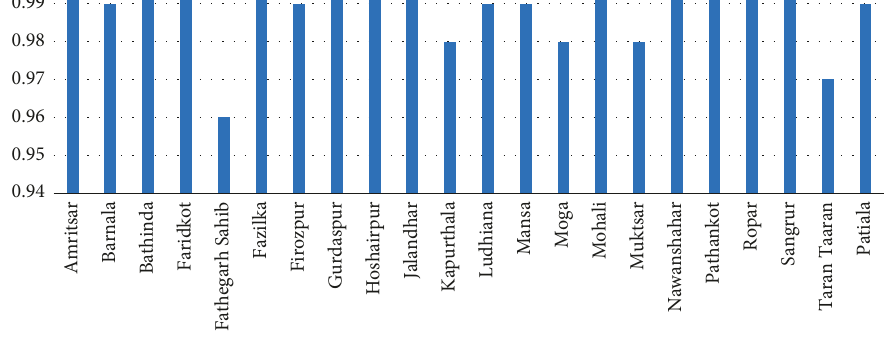
Figure 6: Precision for each district.